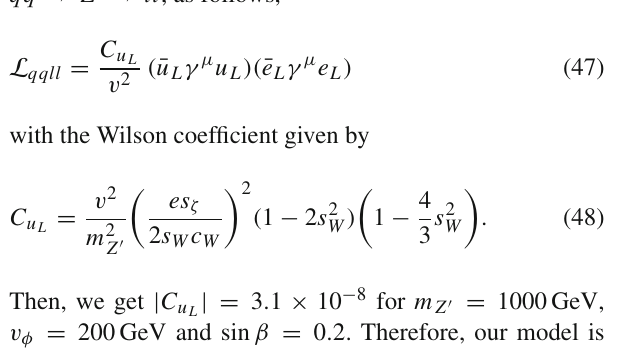
Fig. 4 (cid:15) M W as a function of sin β in black lines. We took M E = 1000GeV and sin θ L = 0 . 010, in common, and v φ = 150 ( 200 ) GeV m Z (cid:2) = 500 ( 1000 ) GeV on left(right). The differences of the W boson mass from the SM prediction in the experimental values obtained from the Fermilab CDFII measurement and the PDG world average are shown within 1 σ errors, in orange and blue regions, respectively. All the regions are consistent with the Z boson decay